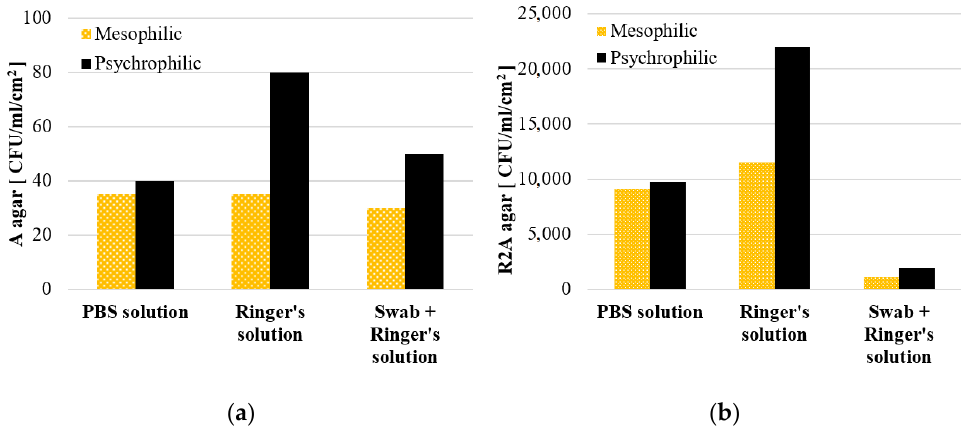
Figure 4. Average number of mesophilic and psychrophilic bacteria on A agar ( a ) and R2A agar ( b ) and using different methods of biofilm detachment.